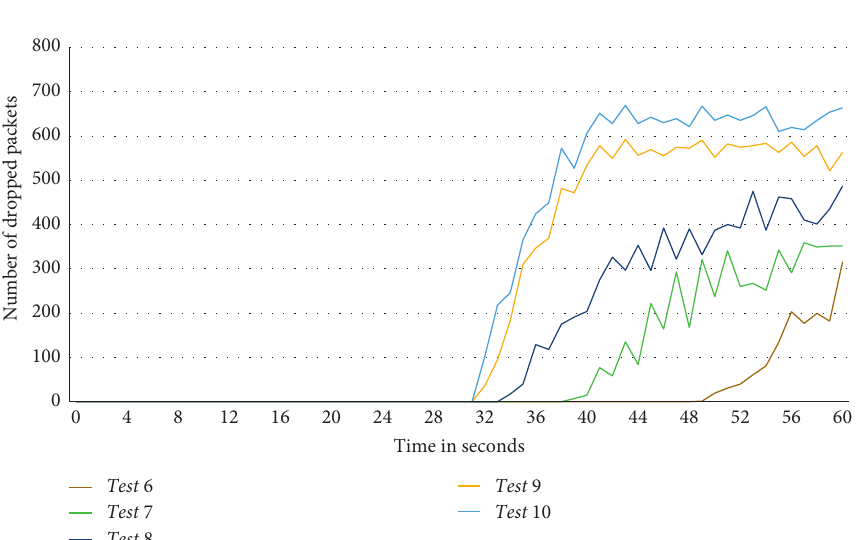
Figure 11: Average percentage of dropped packets.